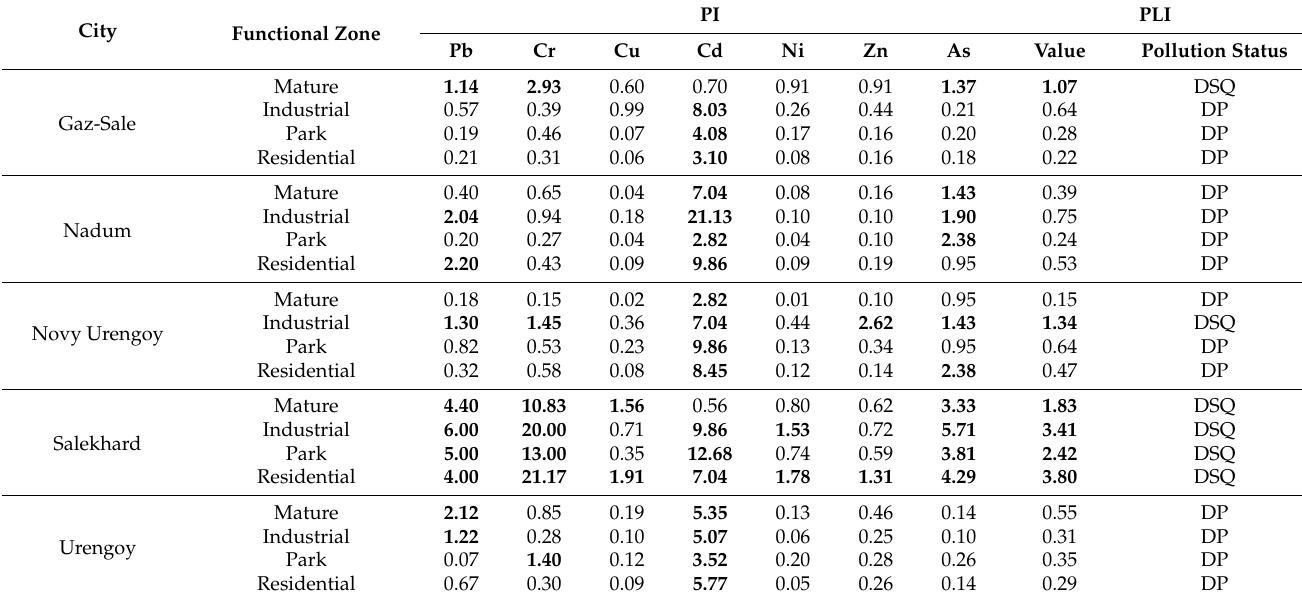
highlighted Igeo coefficient values indicating the presence of contamination. Application of the pollution index mainly showed results identical to the Igeo index, the soils of Salekhard city and its functional zones were recognized as the most polluted. The character of soil contamination in most cases is assessed as strong. The maximum values are revealed for Cr in all functional zones of the city of Salekhard, the nature of the occultation is assessed as very strong. tional zones of the city of Salekhard, mature zone of Gaz Sale and the industrial zone of Novy Urengoy are rated as deterioration of soil quality. Table 8. Values of pollution index (PI) and complex pollution index (PLI) in investigated cities and their functional zones. City Functional